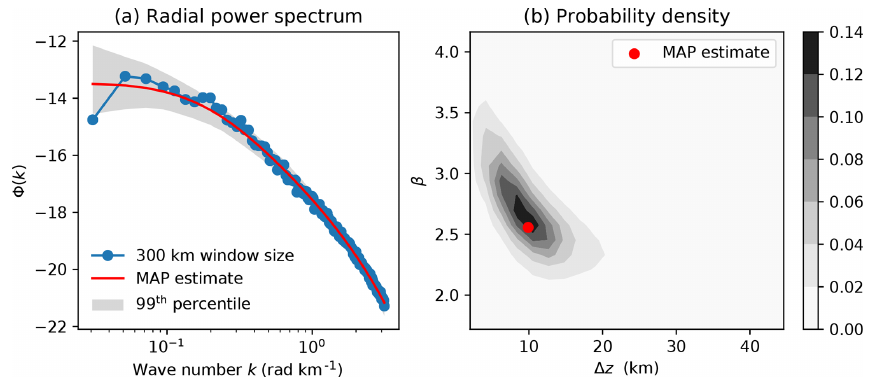
Figure 3. Ensemble of radial power spectra from a MCMC (Markov chain Monte Carlo) simulation. (a) Radial power spectrum computed over a 300km window of a synthetic magnetic anomaly – shaded region indicates the 99th percentile of all models in the ensemble and the red curve is the MAP estimate; (b) joint posterior probability density for β and (cid:49)z – the red dot indicates MAP